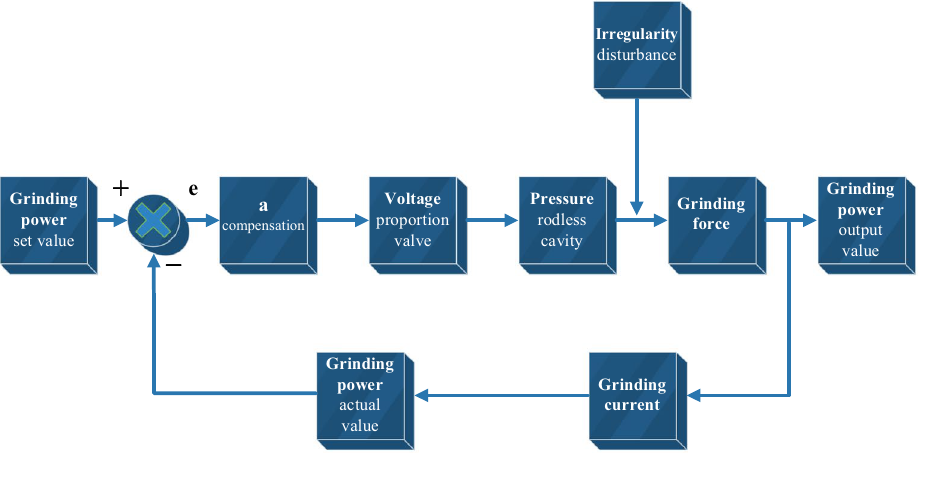
Figure 4. Control